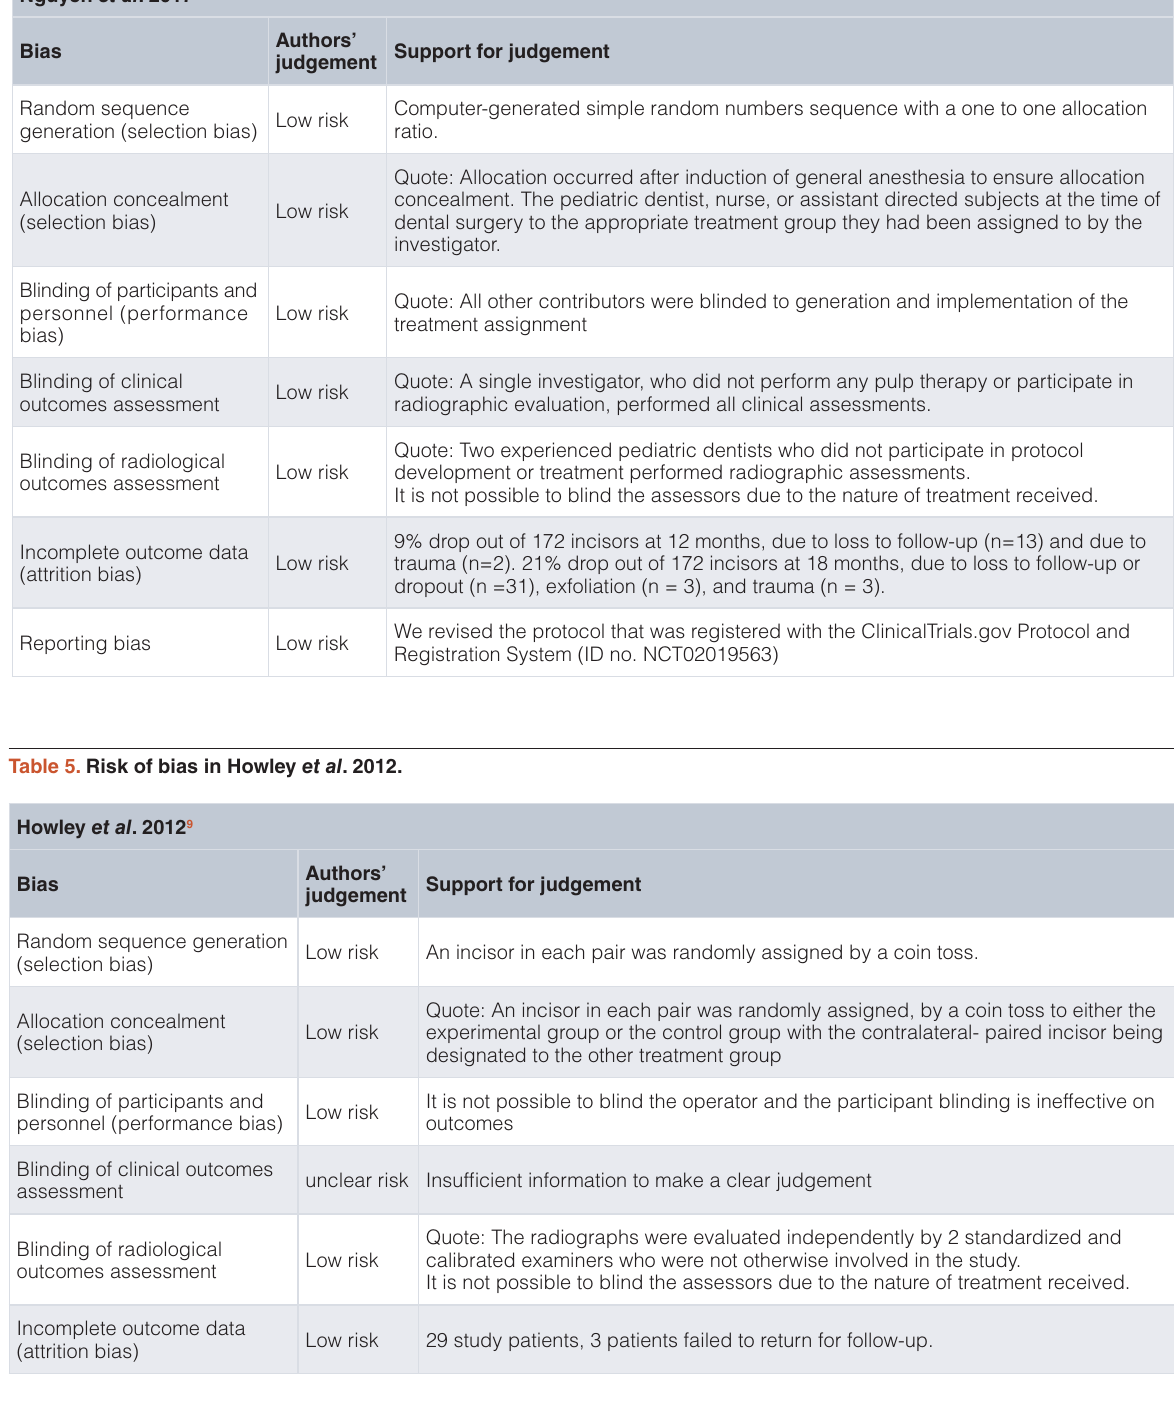
Table 4. Risk of bias in Nguyen et al . 2017. Nguyen et al . 2017 15 Bias Random sequence generation (selection bias)